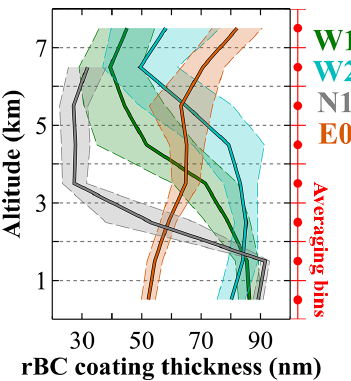
Figure 10. Regime median profiles of black carbon coating thick- ness. Lighter shading represents the median absolute